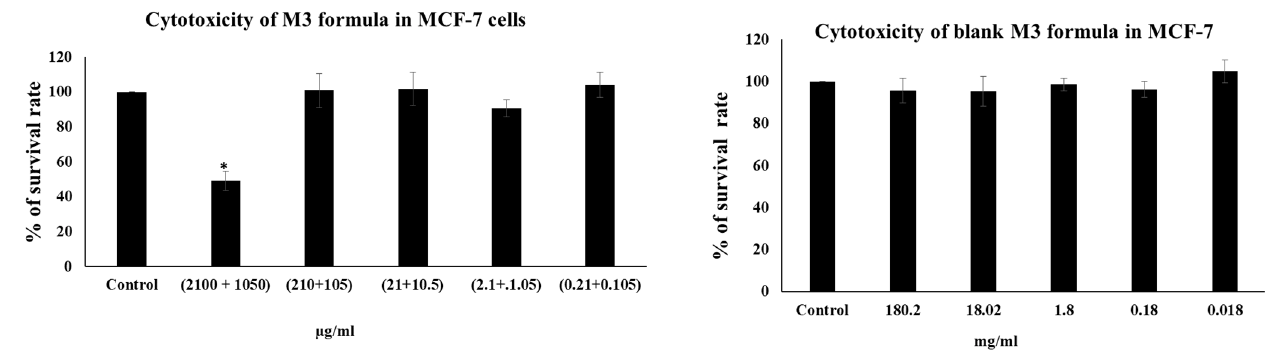
Figure 9. The cytotoxicity of M3 and blank M3 was evaluated by MTT assay (Means + S.D). * p < 0.05 compared with control.